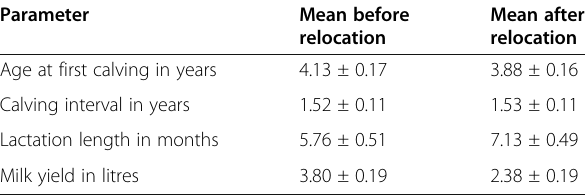
Table 4 Cattle performance before and after the relocation